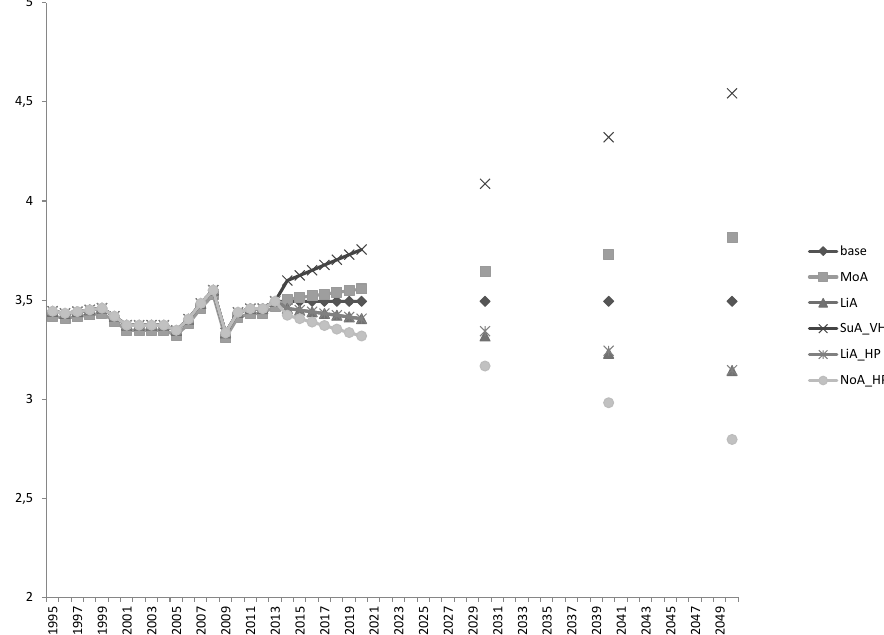
Fig. 3. Yield level for barley (kg Nha -1 ) in different scenarios, southern Finland, support region B. Base=Baseline; MoA=Moderate adaptation (yields +10%); LiA = Little adaptation (yields –10%); SuA_VHP = Successful adaptation, very high prices (yields +30%, crop prices+30%); LiA_HP = Little Adaptation, high prices (yields –10%, crop prices +10%); NoA_HP = No adaptation, high prices (yields –20%, crop prices The increasing yield potential takes place gradually over 2014–2050 in the scenarios, while price changes take place already in 2020–2030. This implies that N fertilization increases faster than the yields. Furthermore, the empirically validated N response functions suggest that the relative increase in N fertilization is larger than the re- sulting increasing crop yields. This, in turn, results in smaller profits per ha from increased yields than suggested by increased crop yields as such, and increasing N balances.